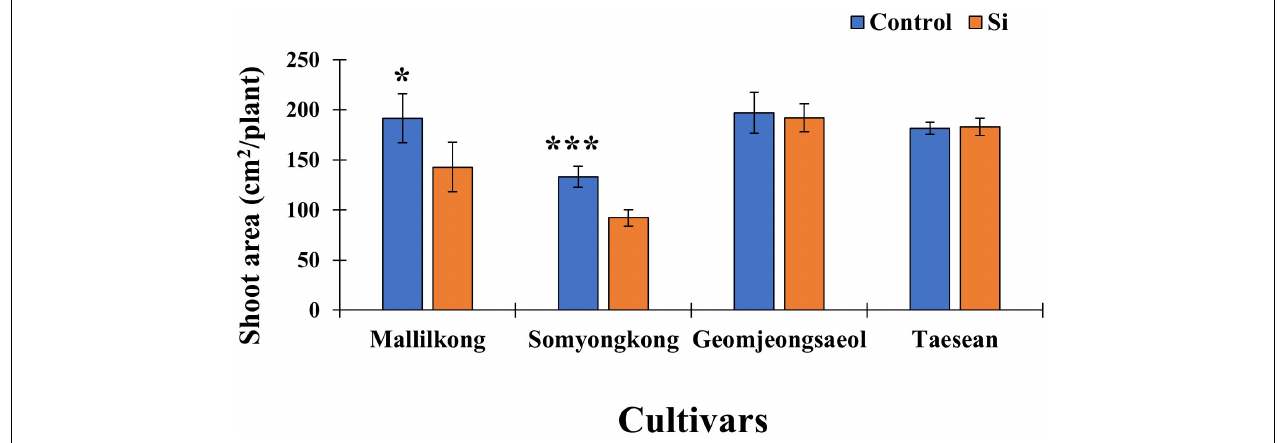
FIGURE 3 | Silicon effect on the shoot area in selected soybean cultivars. The data were collected at different periods, and the blue and orange bars represent control and Si treatment, respectively. In the figure, the vertical bar means average and error bars indicate standard error. The experiment was conducted by five replications ( n = 5 ). Error bars indicate standard error, and the asterisks indicate significant difference using the Student’s t -test (*0.01 < P < 0.05; *** P <